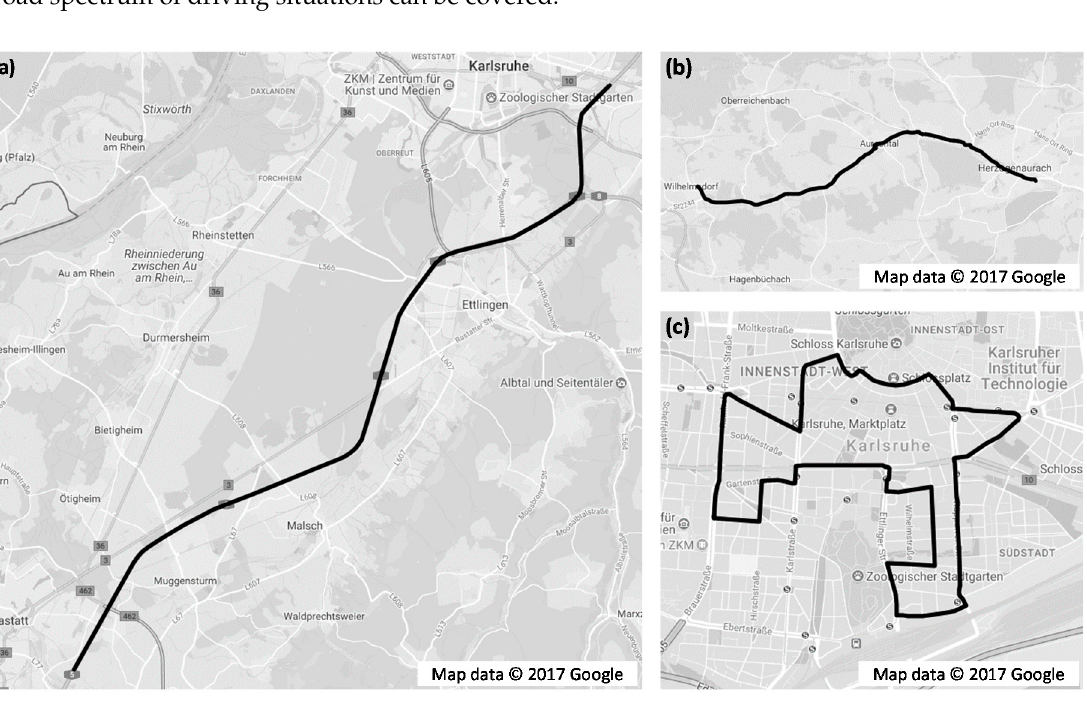
Figure 5. Realistic driving cycles: ( a ) Karlsruhe motorway, ( b ) Herzogenaurach highway, ( c ) within